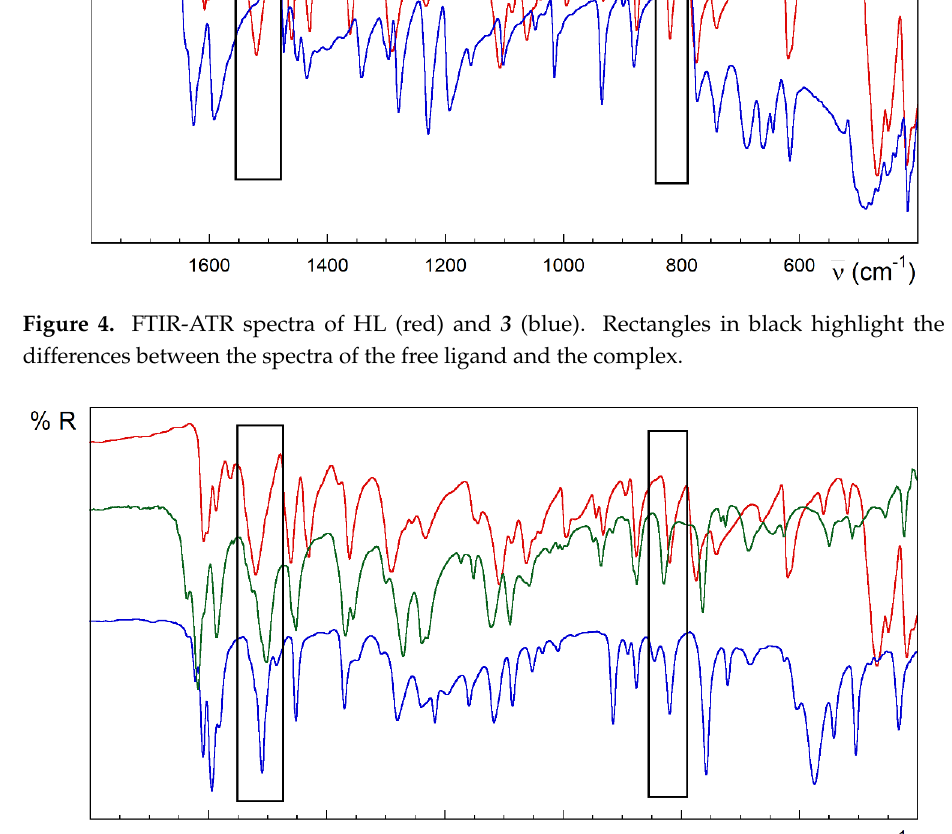
Figure 5. FTIR-ATR spectra of HL (red), (H 2 L)Cl∙H 2 O (green) and 4 (blue). Rectangles in black show bands in the same spectral regions for the three compounds.